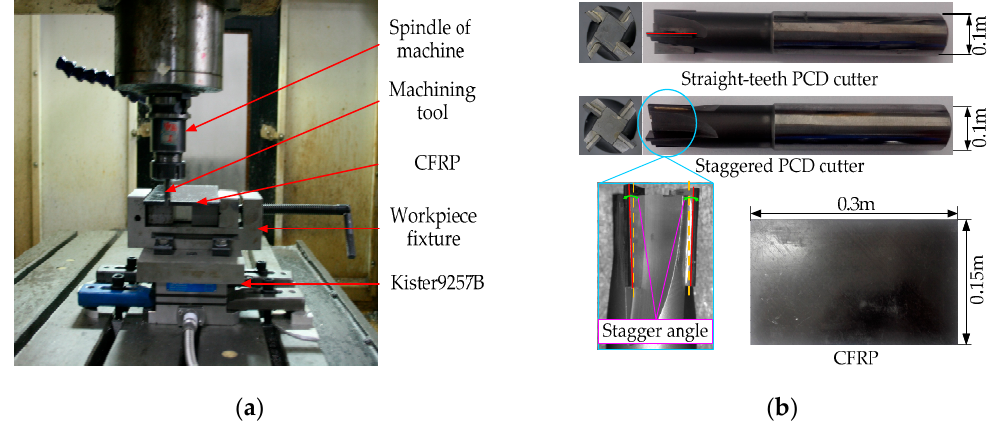
Figure 1. Test system: ( a ) test layout; ( b ) cutting tool and workpiece.